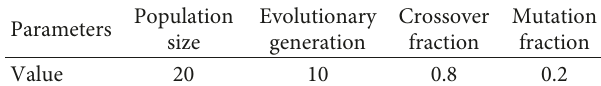
Table 3: Main parameters of GA.